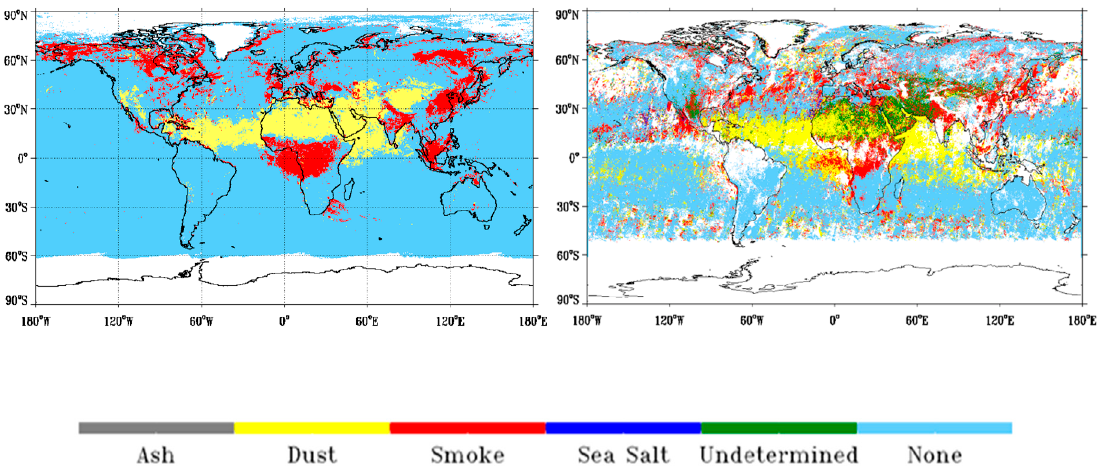
Figure 7. The VIIRS Aerosol Detection Product (ADP) ( left panel ) is found to be in good agreement with Multiangle Imaging Spectroradiometer (MISR) ( right panel ), with respect the location of dust and smoke. The ADP enterprise algorithm is currently running on S-NPP (NDE) and meets the performance requirements. (Figure courtesy: Shobha Kondragunta/Istvan Laszlo, STAR Aerosol team). Table 7. S-NPP VIIRS atmosphere products performance.